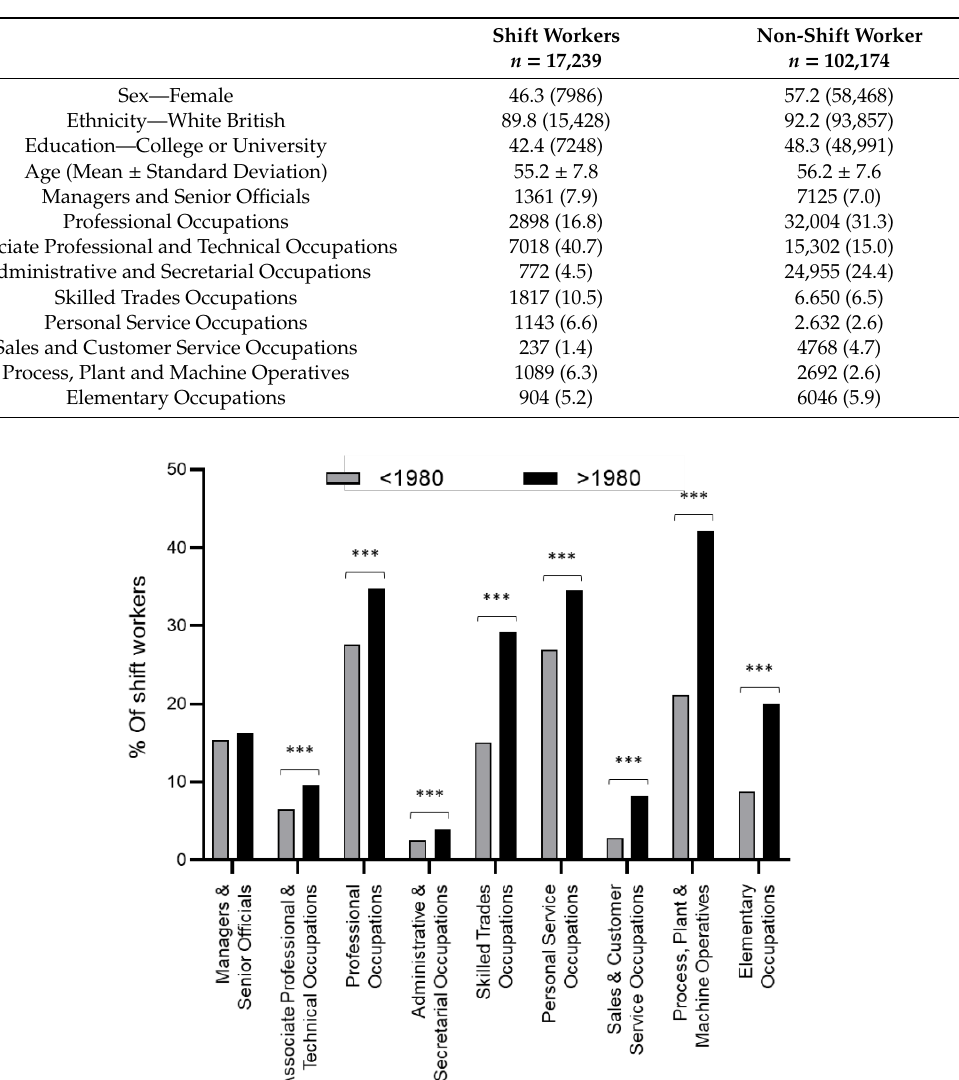
Table 1. Sample characteristics.